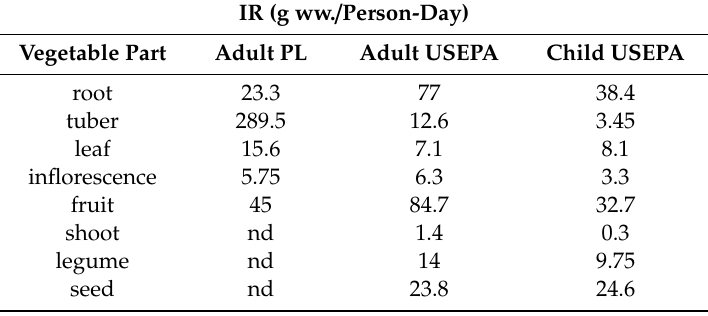
Table 2. Intake rates (IR) (g ww. / person-day) of the consumed groups of vegetables. IR (g ww. /